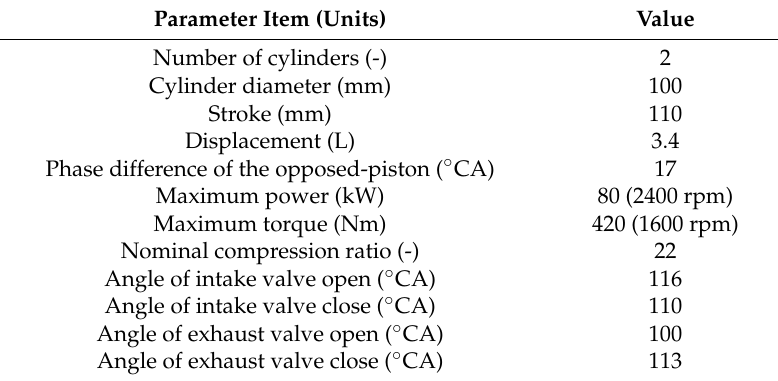
Figure 2. Configuration of OP2S diesel engine. Table 1. Parameters of the OP2S diesel engine.